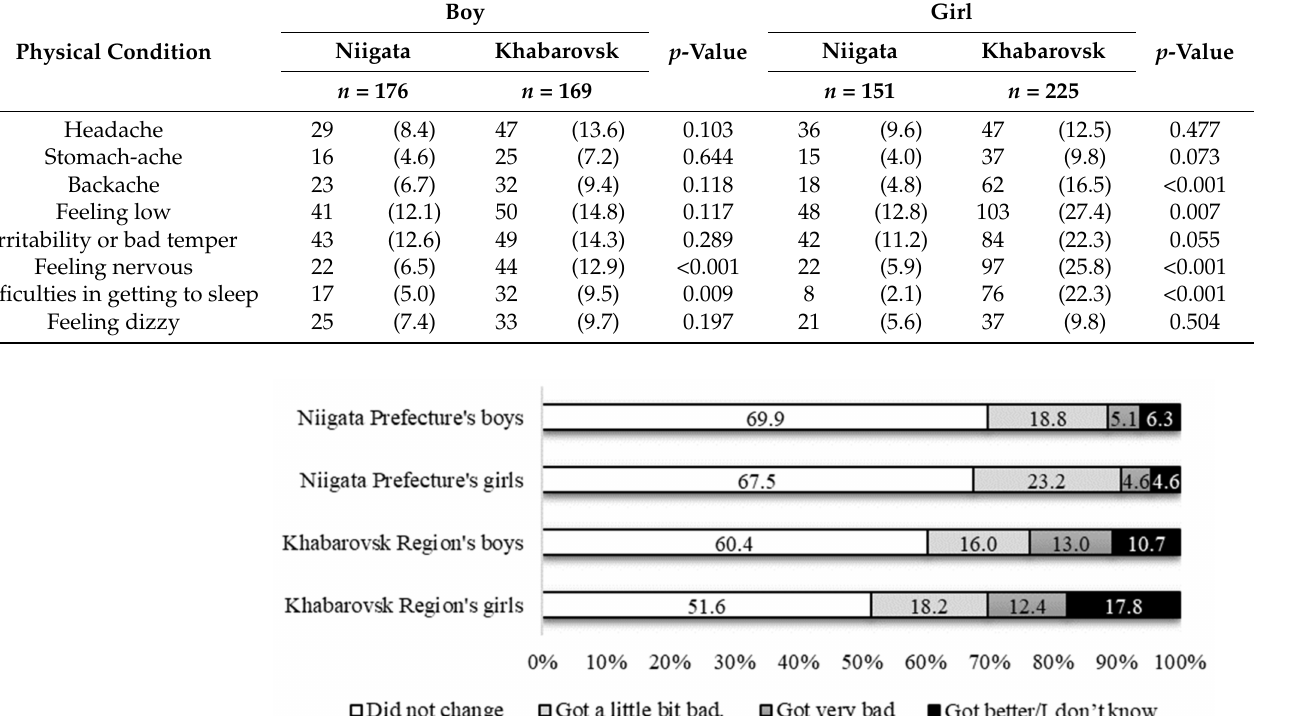
Table 3. The number and percentage of respondents who answered more than once a week to the